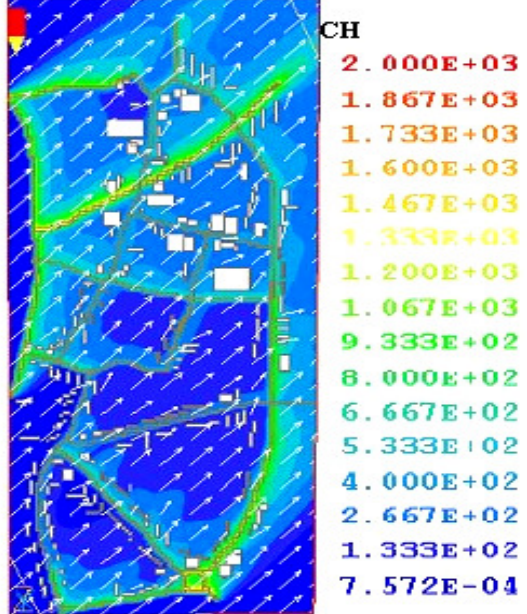
Fig 9. The modelling results of scatter of CH x (CH) con- 3 ) in Žirmūnai when the wind blows from centration ( µ g/m the southwest at 3 m/s speed